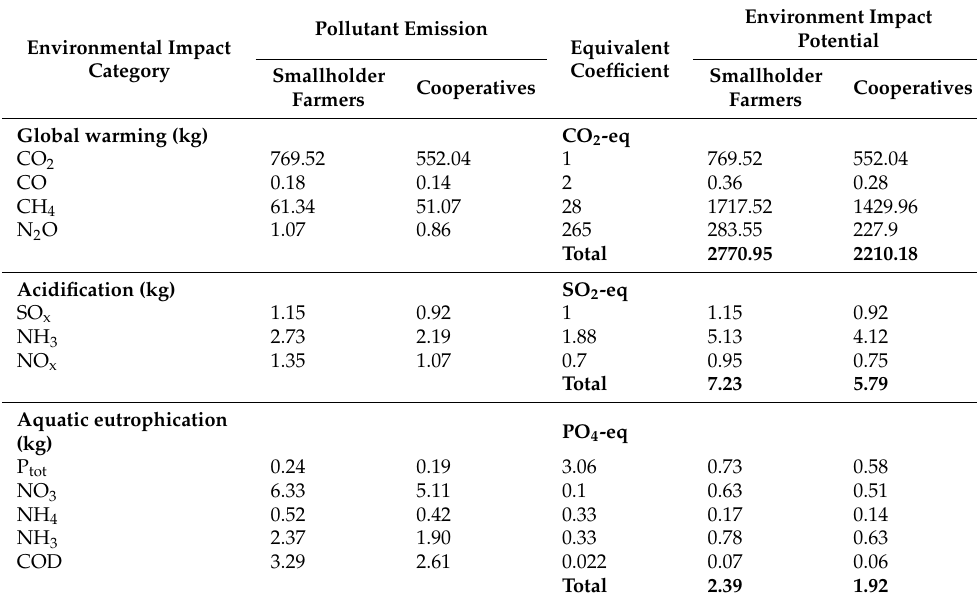
Table 4. Characterization of per ton of apple production in pollutant